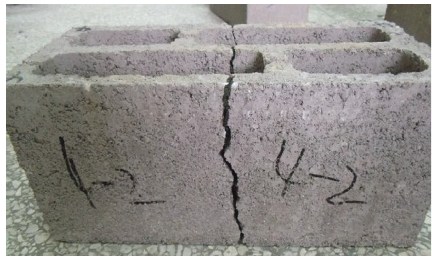
Figure 10: Failure modes of